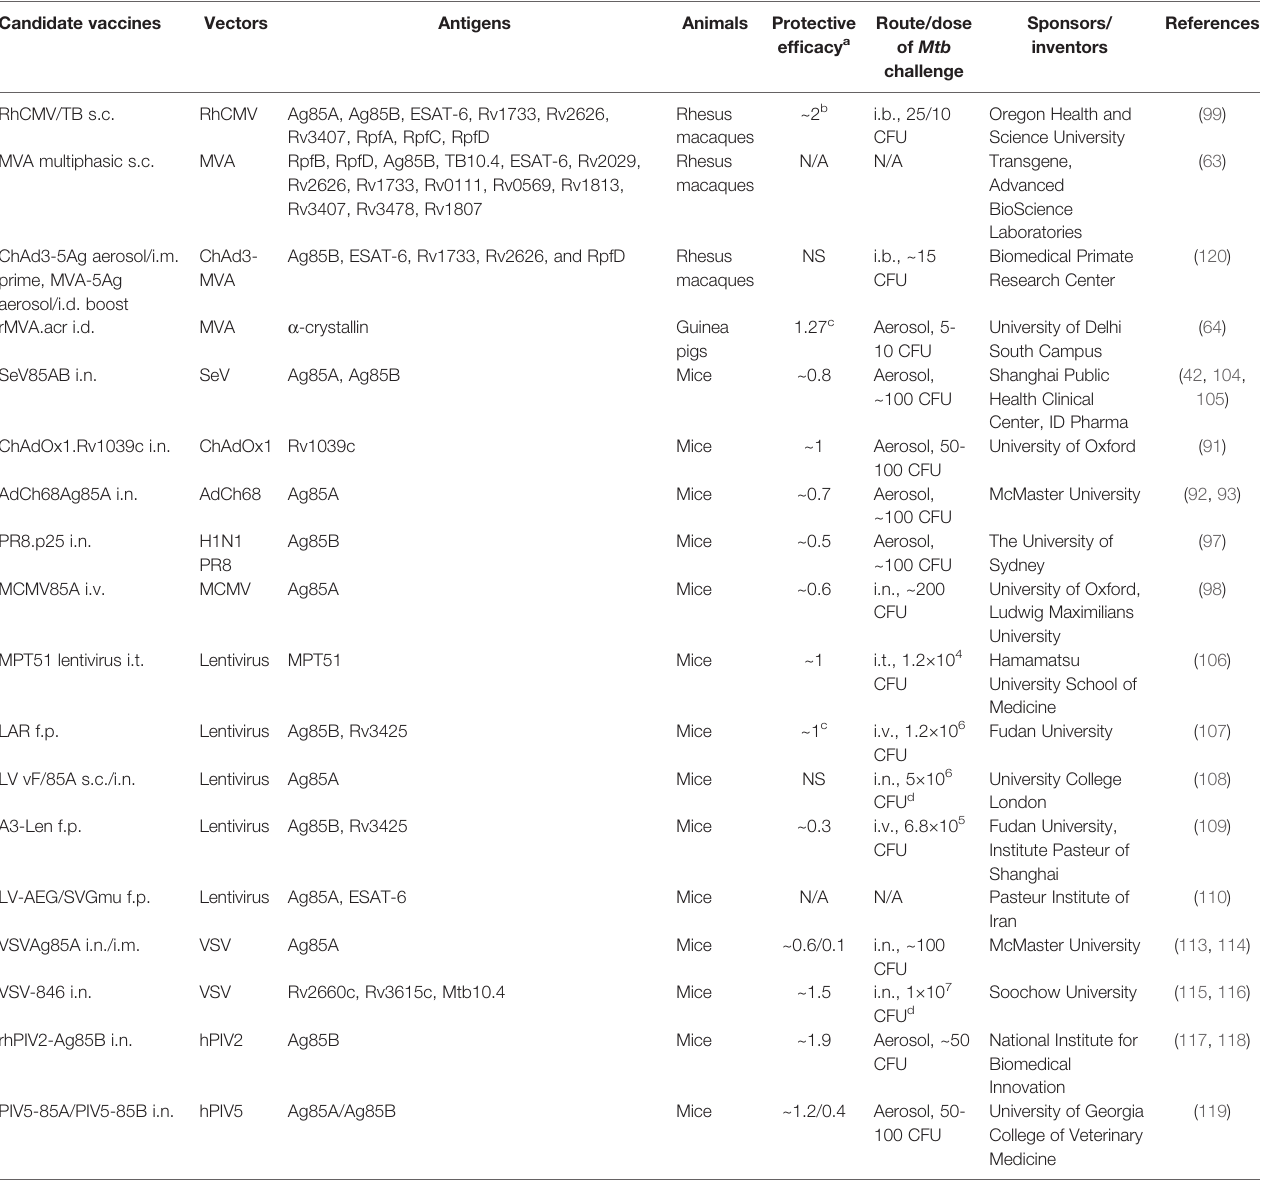
TABLE 2 | Viral vectored TB vaccine candidates that are currently in preclinical animal model